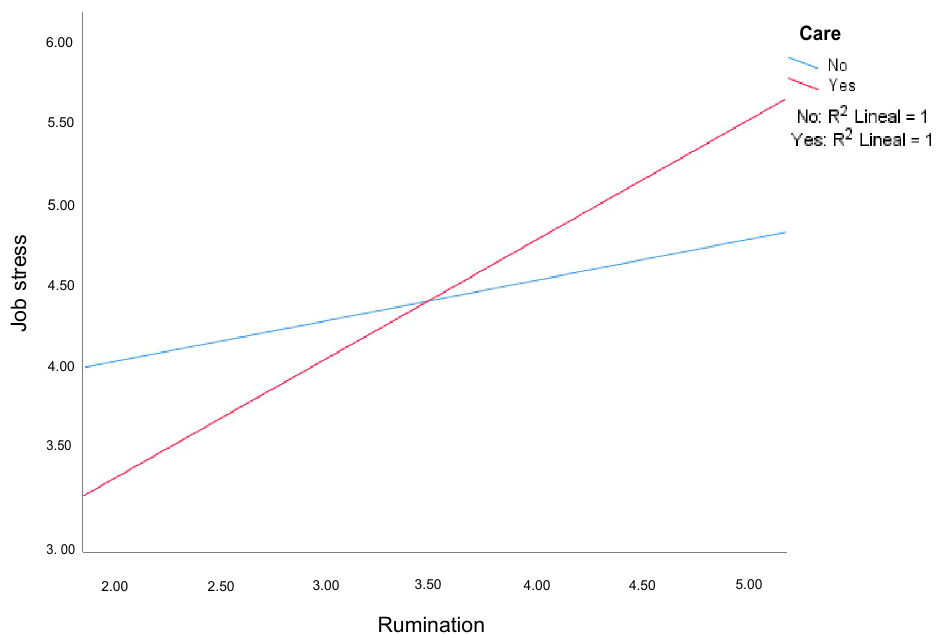
Figure 2. Influence of rumination on work-related stress as a function of caregiving in a face-to-face work setting.